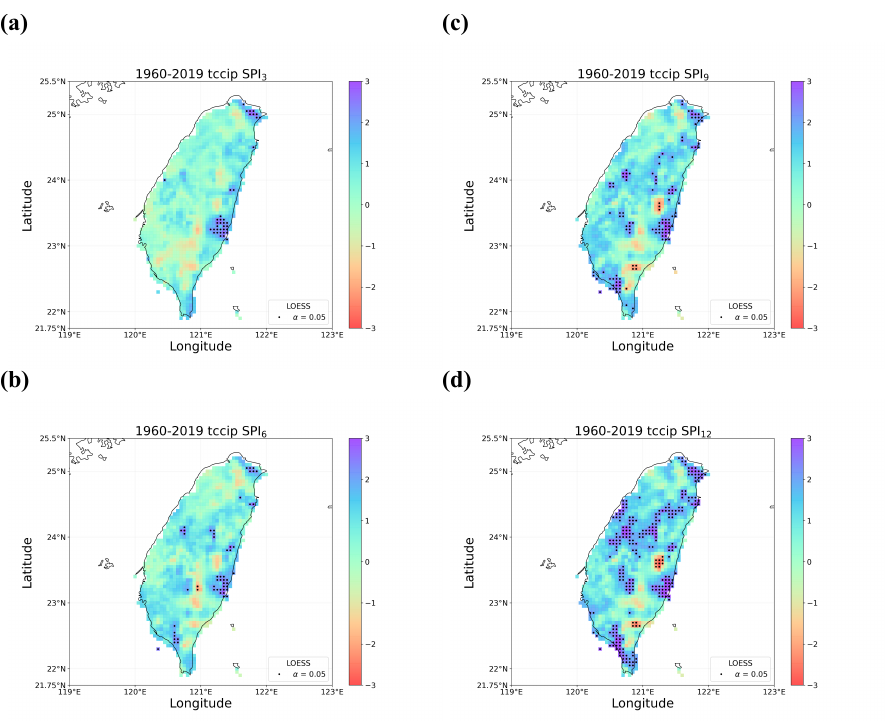
Figure 4. The same as Figure 2, but for detected trends using locally estimated scatterplot smoothing